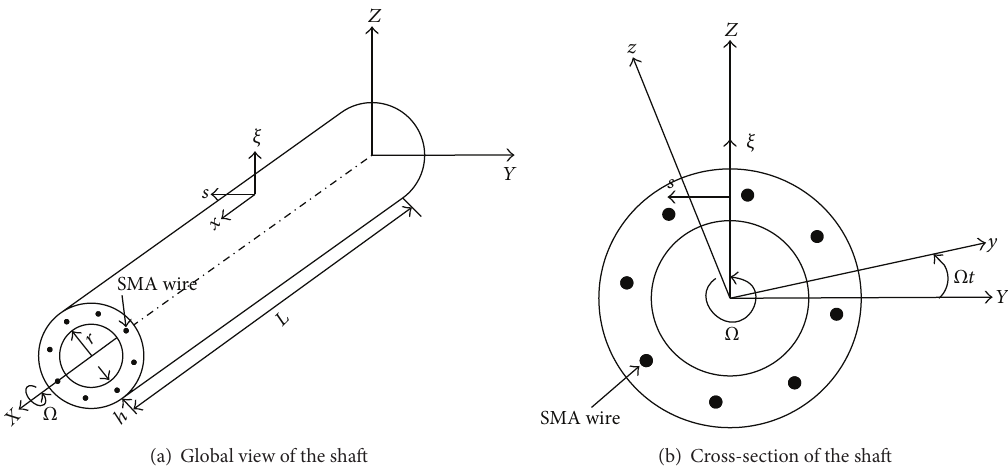
Figure 1: Schematic drawing of the composite thin-walled beam of a circular